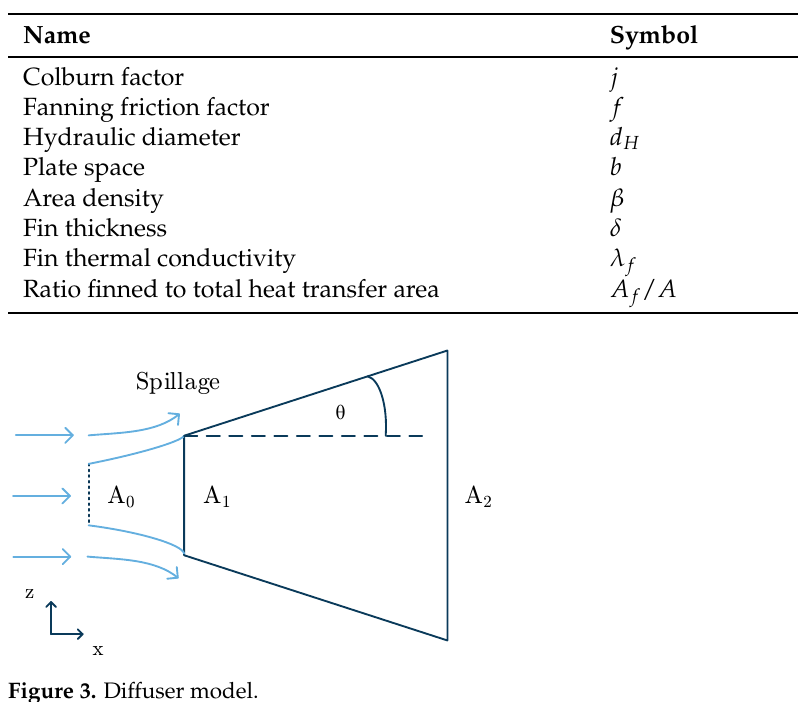
Table 1. Required heat exchanger core parameters.